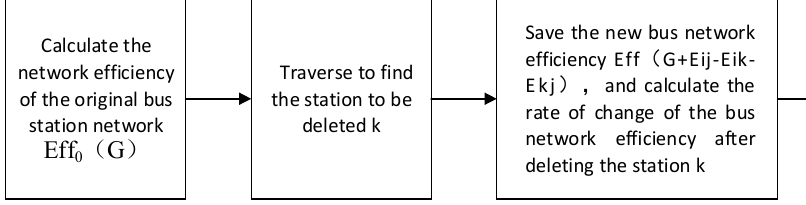
Figure 4. Delete bus station.